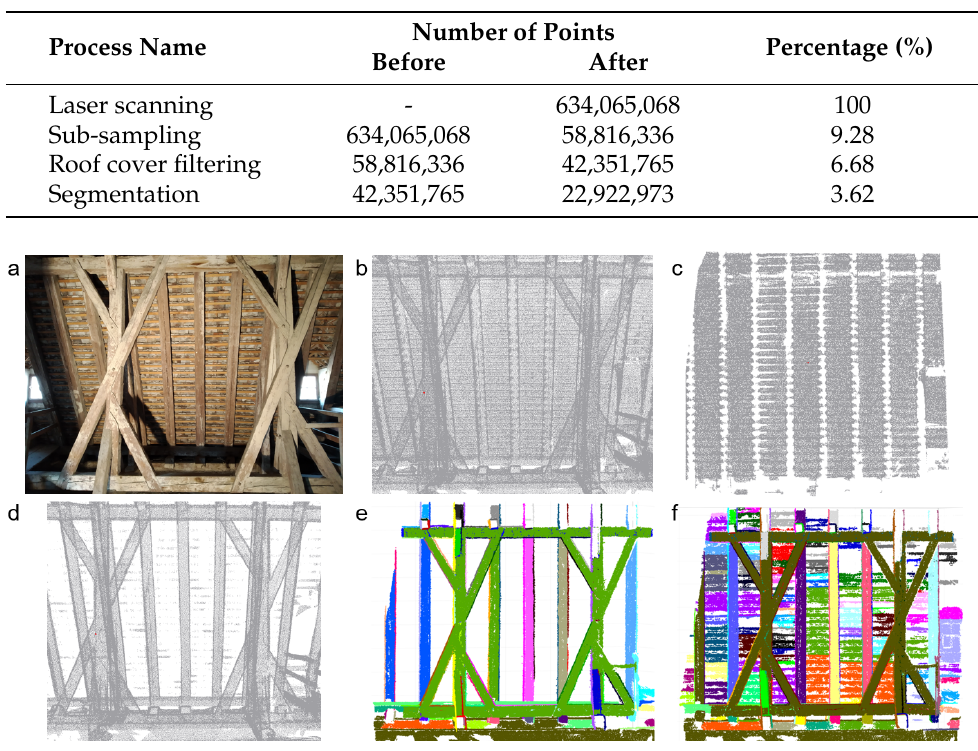
Table 1. Number of processed points in context of decimation.